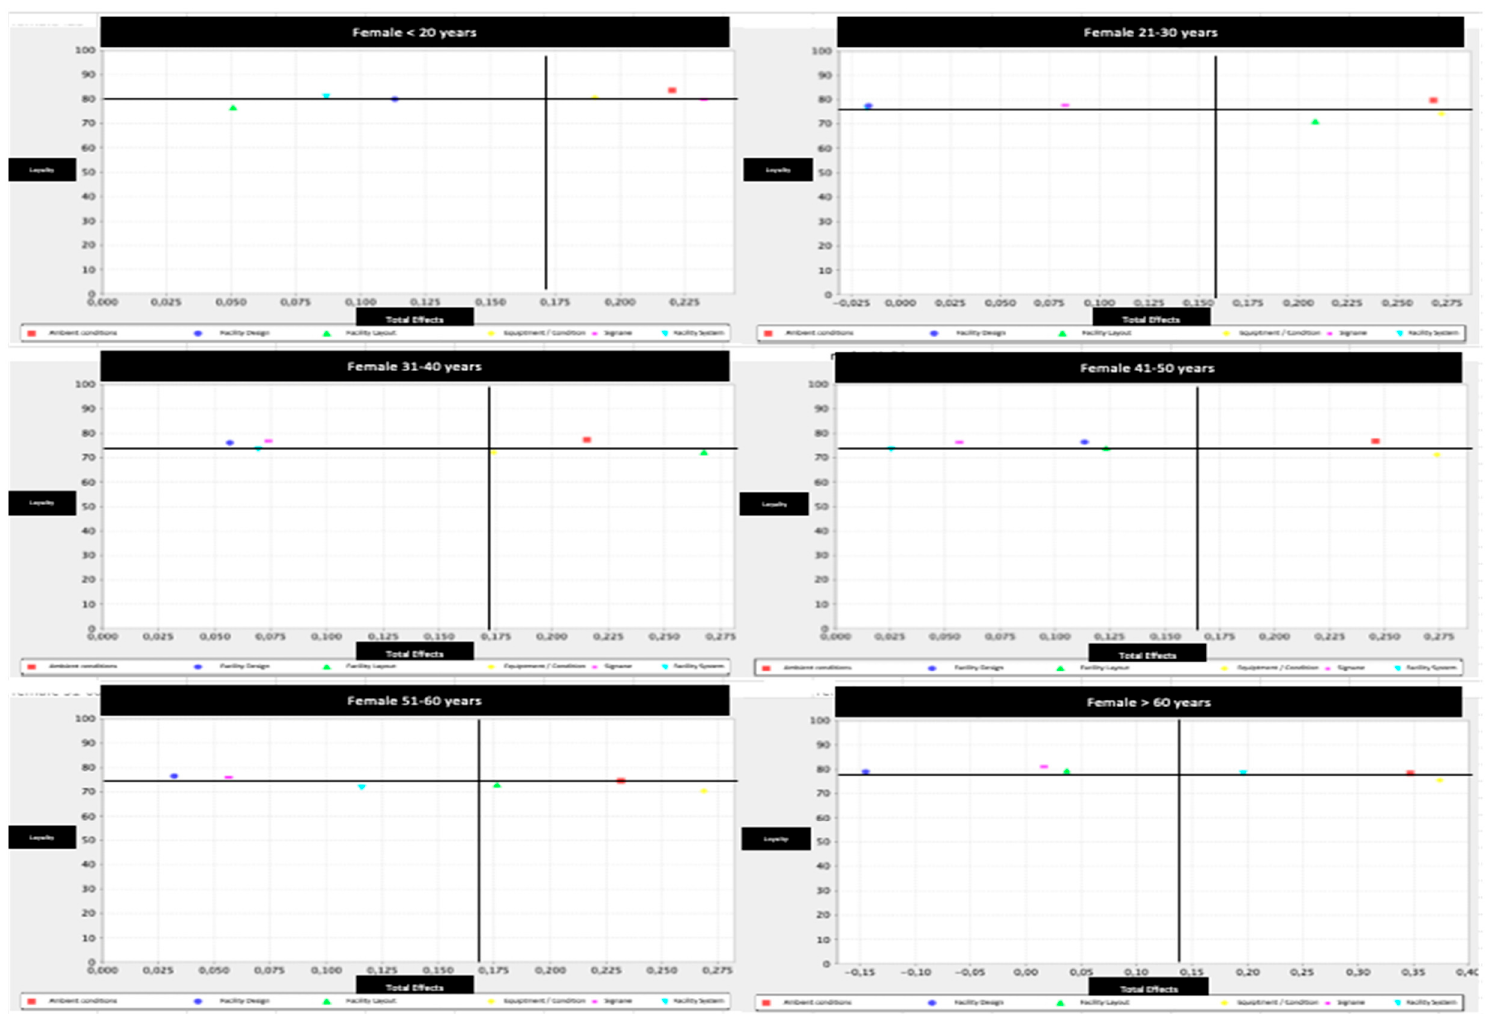
Figure 4. Importance-performance map by female and age group. Note: Red: ambient condition; Strong blue: facility design; Green: facility layout; Yellow: equipment/facility condition; Pink: signage; Light blue: facility system.